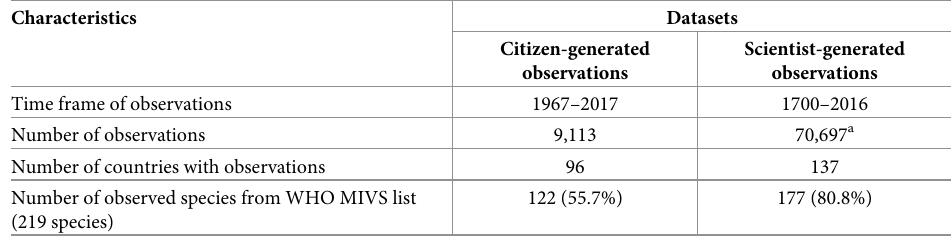
Table 1. General characteristics of citizen-generated observations and scientist-generated observations datasets.